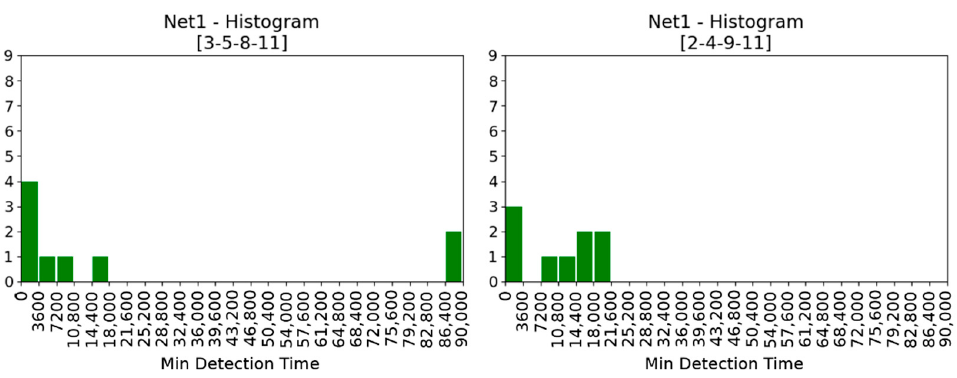
Figure 4. The histogram of a sensor placement with p = 4 (| A | = 9). We have added an “extra” bin (86,400 to 90,000) whose weight |𝐴 (cid:3038)(cid:2878)(cid:2869) | represents number of contamination events which were undetected during the simulation up to 86,400. In this way ∑ |𝐴 (cid:3036) | (cid:3038)(cid:2878)(cid:2869) | A | = (cid:3036)(cid:2880)(cid:2869) i i = 1